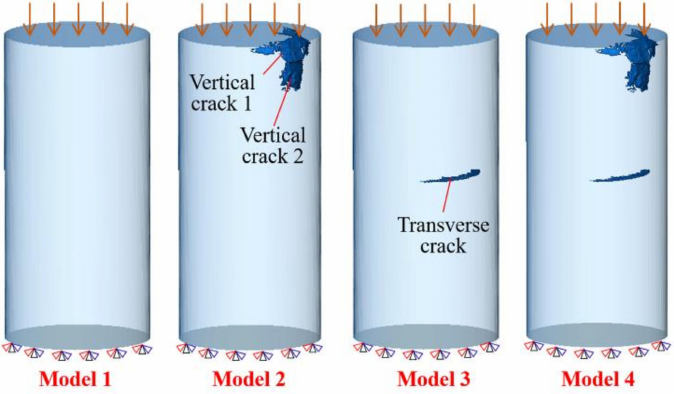
Figure 10. Three-dimensional finite element